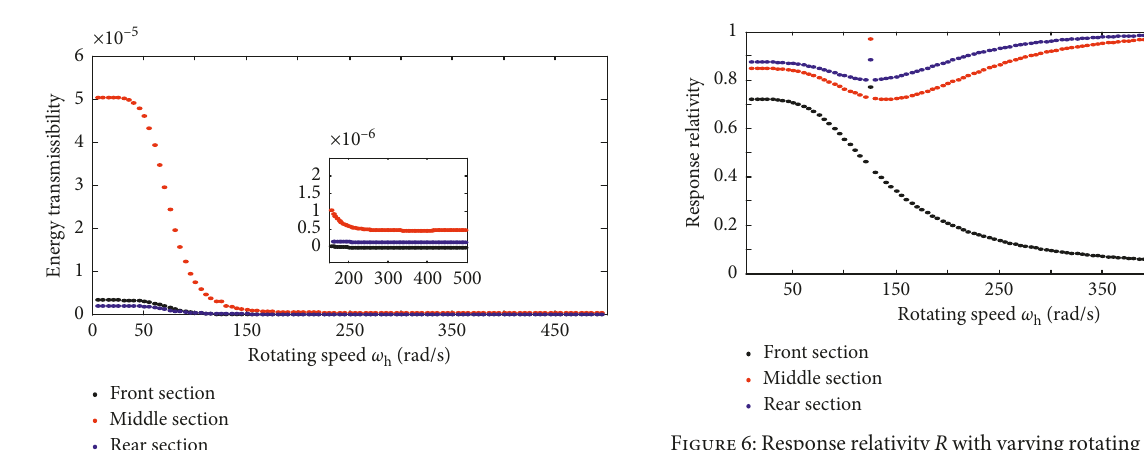
Figure 6: Response relativity R with varying rotating speed of high- pressure rotor ω h : front section (black), middle section (red), and rear section (blue).